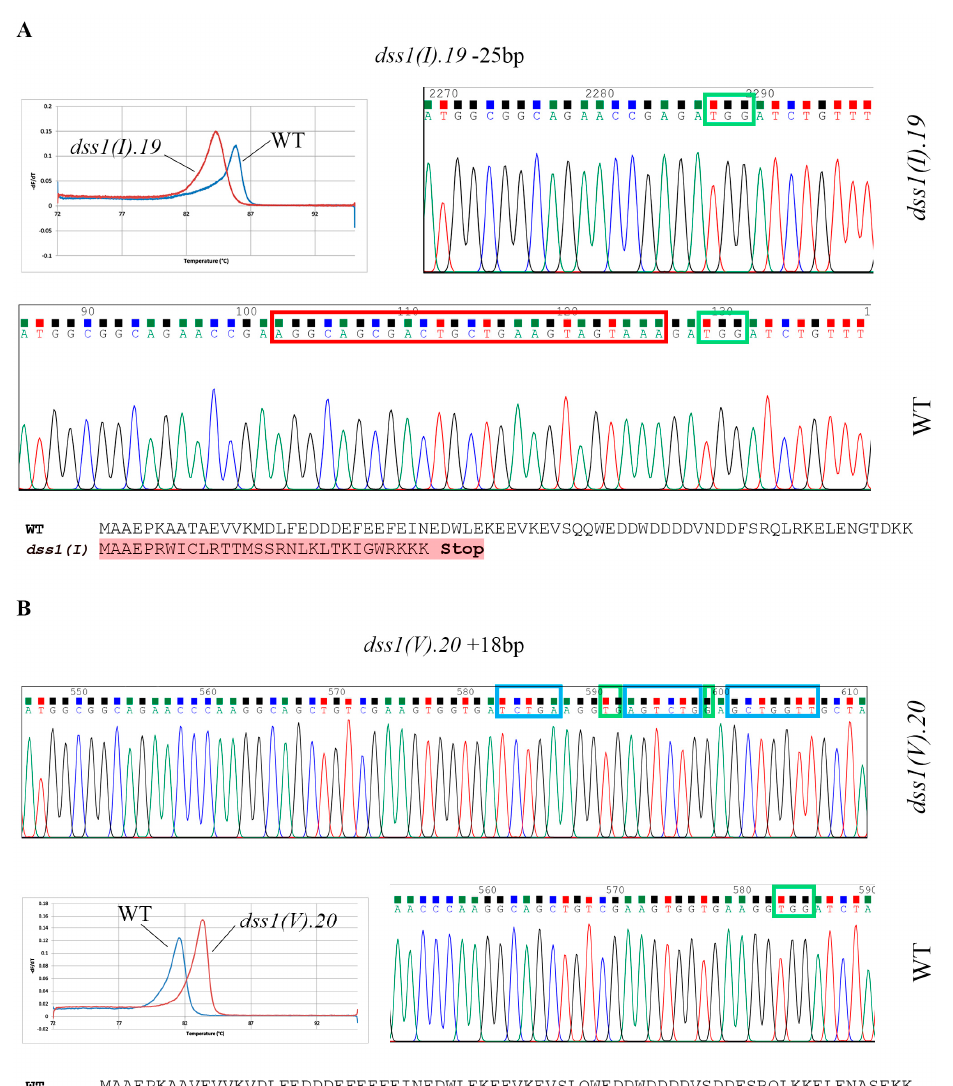
Figure 4. Mutation analysis of T3 generation. ( A ) HRM profiles, DNA-sequence chromatograms and amino acid sequences of the homozygous dss1(I) mutant and WT plant. ( B ) DNA-sequence chromatograms, HRM profiles, and amino acid sequences of the homozygous dss1(V) mutant and WT plant. Green squares represent PAM sequence, red square marks 25 nt of WT sequence that are deleted in mutant line named dss1(I).19 ; blue boxes mark 18 nt of insertion in dss1(V).20 mutant line. The derived protein sequences were obtained by using ExPASy Translate tool (http://web.expasy. org/translate/; accessed on 28 July